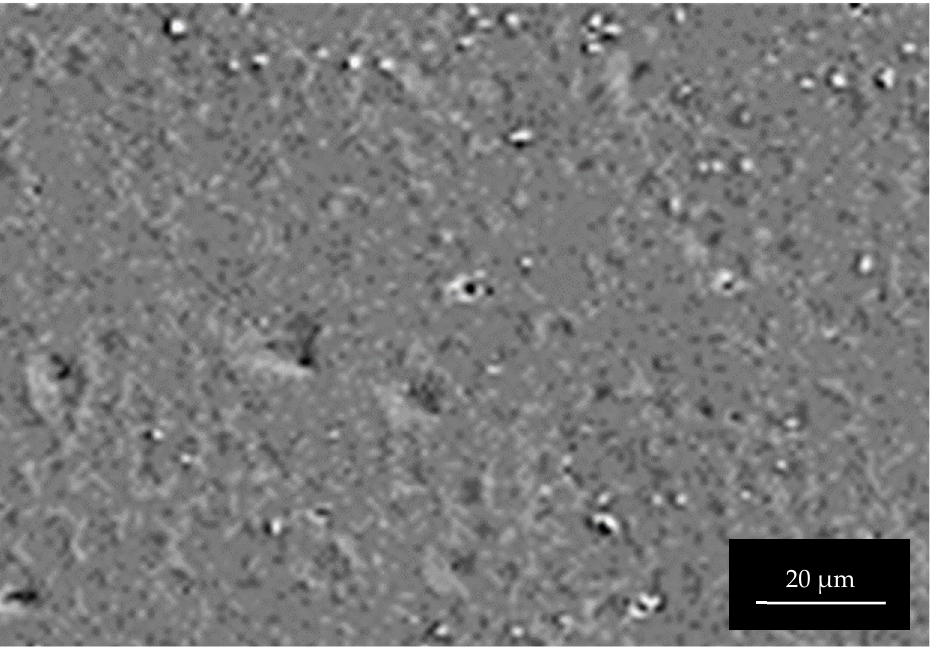
Figure A5. Surface of 1050-Al alloy with t a = 3600 s and t s = 1200 s. Figure 10a was enlarged to 500%.